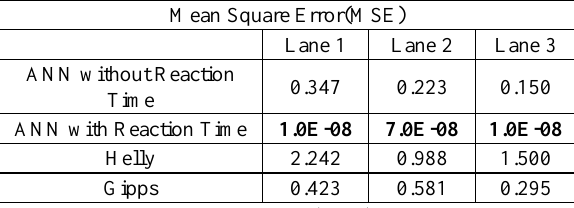
Table 1. The mean squared error (MSE) between the real data and the output of models with reaction time and without